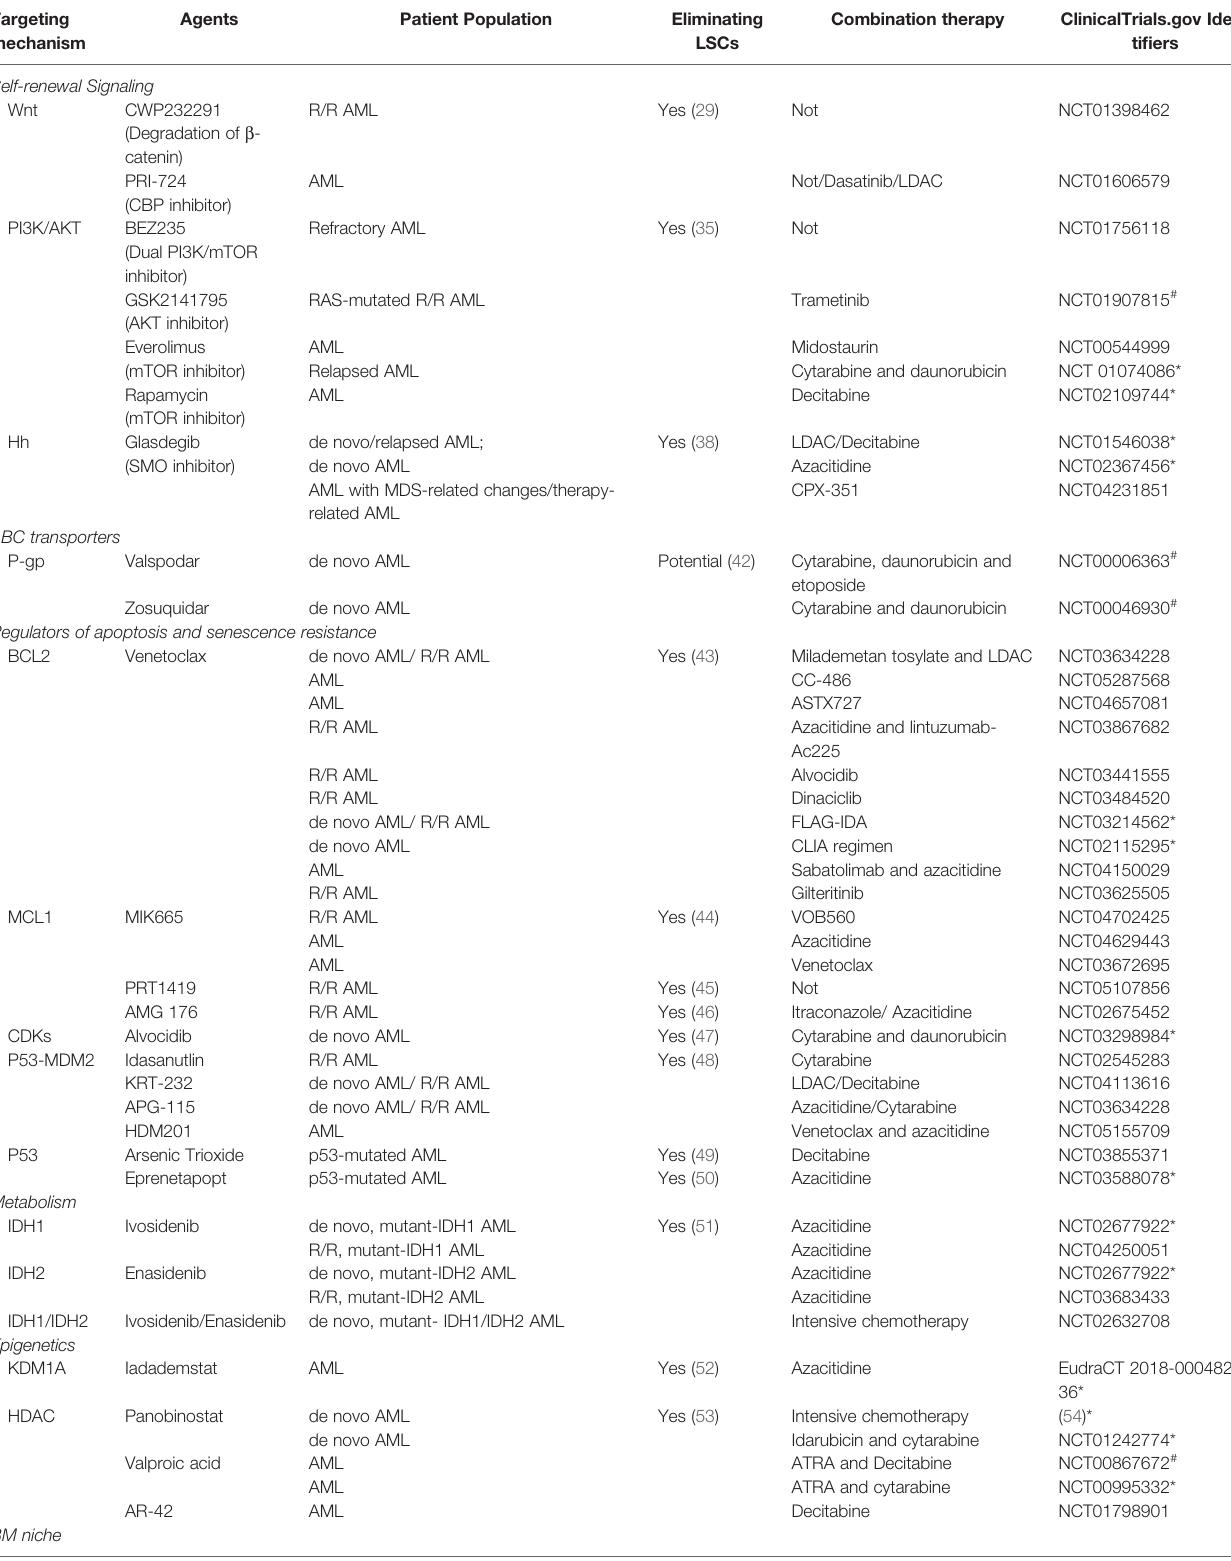
TABLE 1 | Clinical trials of targeted therapies in